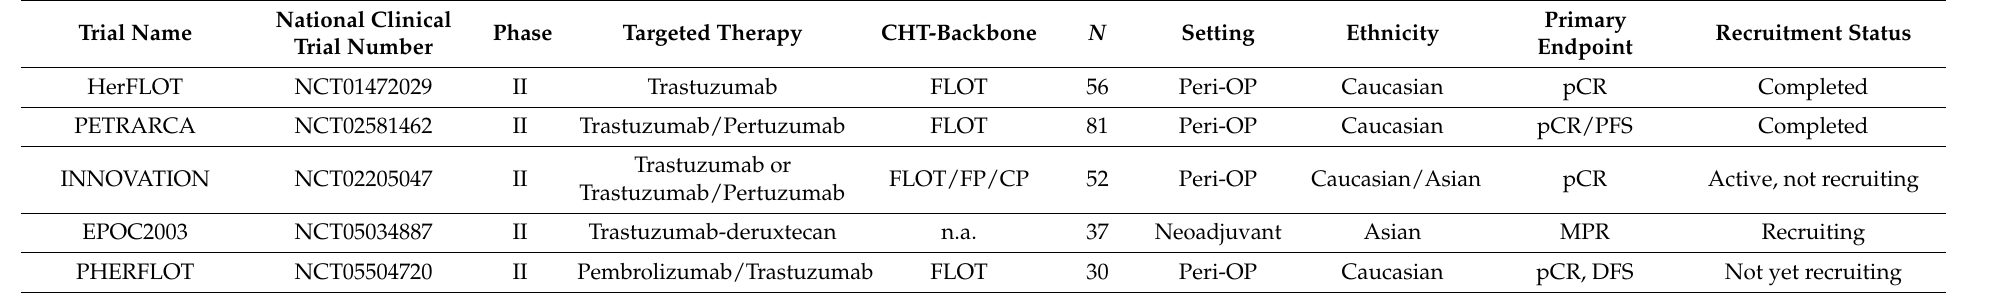
Table 2. Clinical trials targeting Her2 in localized gastroesophageal